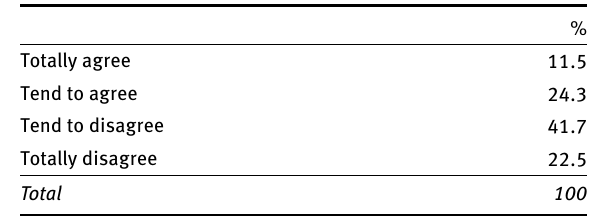
Table 6: Robots could be used to reduce and limit human’s